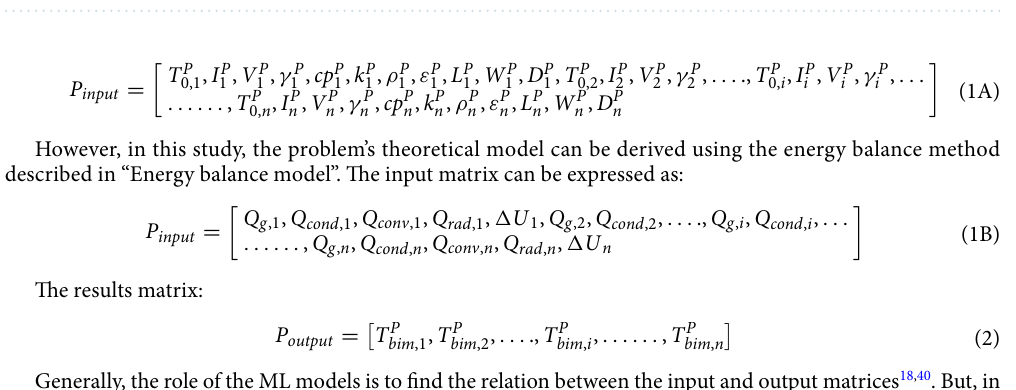
Figure 2. The requirements of IEC-60898-1 standard related to the bimetal design, genegrated using “ANSYS Spaceclaim R2 2021” 38 (https:// www. ansys. com/ produ cts/ 3d- design/ ansys- space